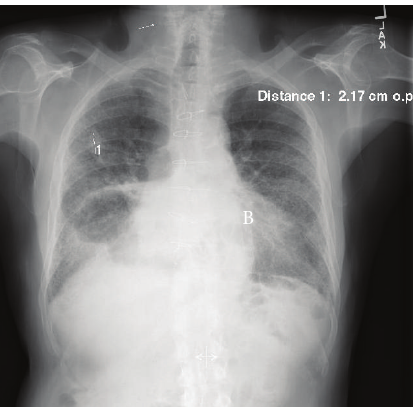
Figure 1: AP chest radiograph showing extensive bilateral reticular- fibrotic pattern with honeycombing and a 2.17 cm nodule in right upper lobe of his lungs.